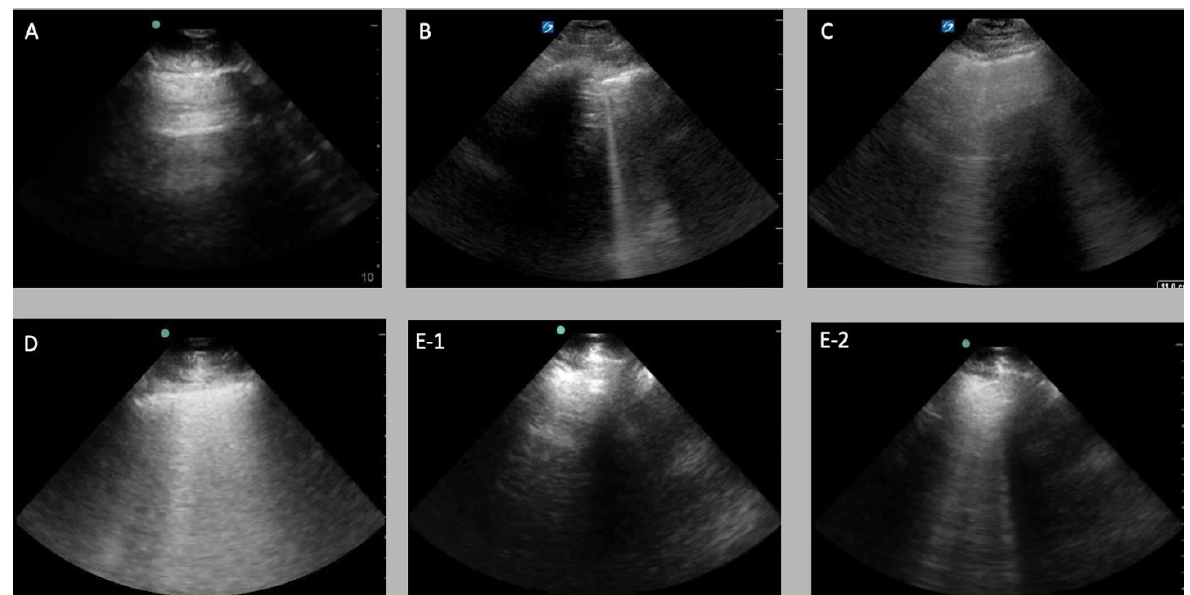
Figure 2. Still image representations of the various lung ultrasound artifacts, severity and heterogeneity applied as labels to our data: ( A ) A-line pattern (normal lung) class; ( B ) fewer than 3 B lines class; ( C ) moderate B line class; ( D ) severe B line class; ( E ) 2 frames showing heterogeneity within the same clip with A lines ( E-1 ) followed by moderate B lines ( E-2 ) sliding in to view.